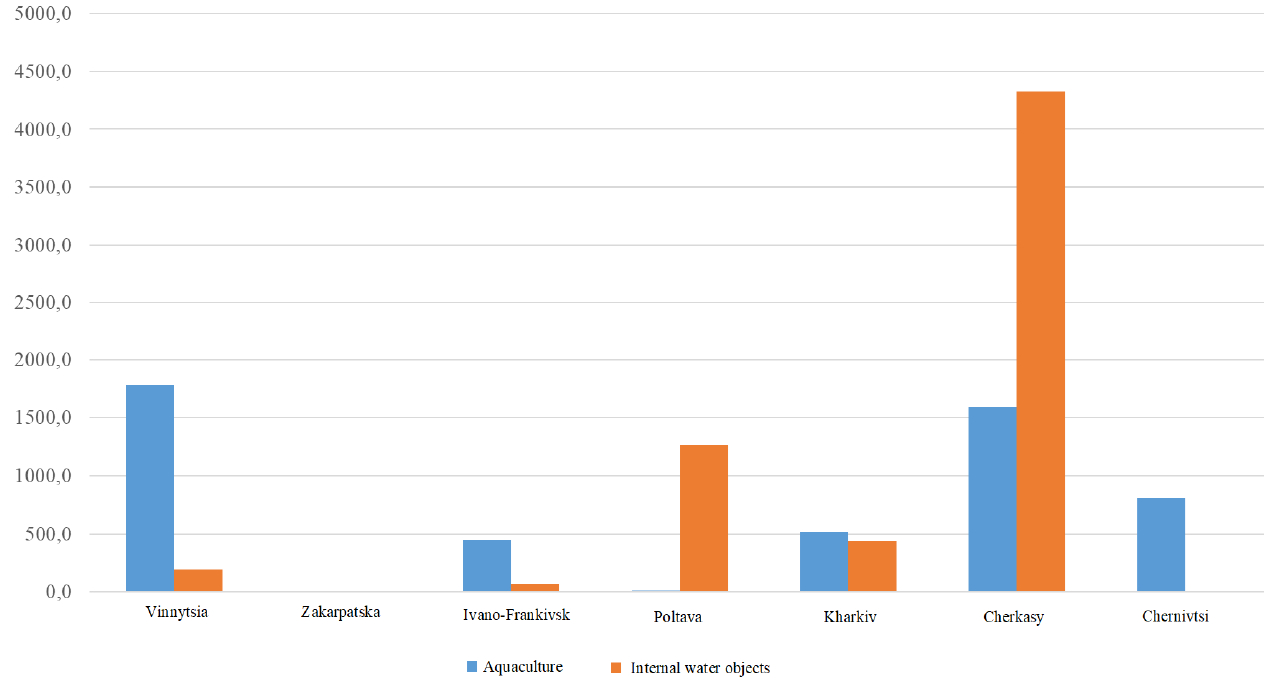
Fig. 5. Extraction of aquatic organisms in inland water bodies and aquaculture of the IV fish-water zone for the territory of Ukraine,